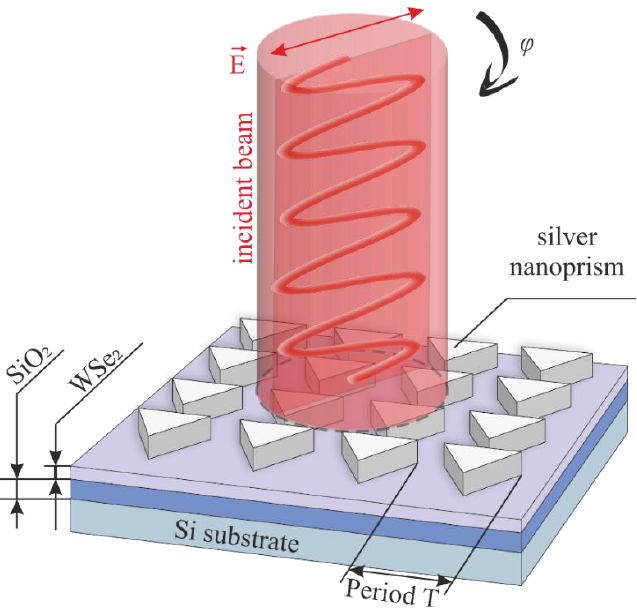
Figure 1. Schematic representation of an ordered triangular silver nanoprism on the surface of a 2D WSe 2 film.